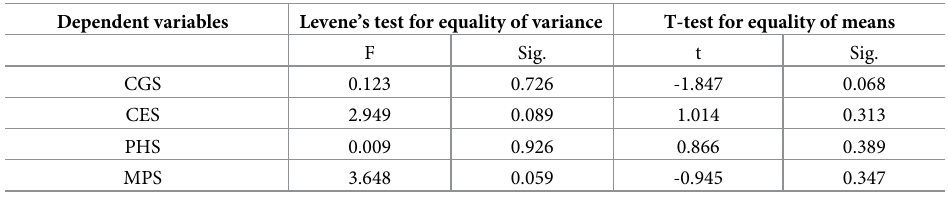
Table 4. T-test for the influence of gender on the skills of MICE